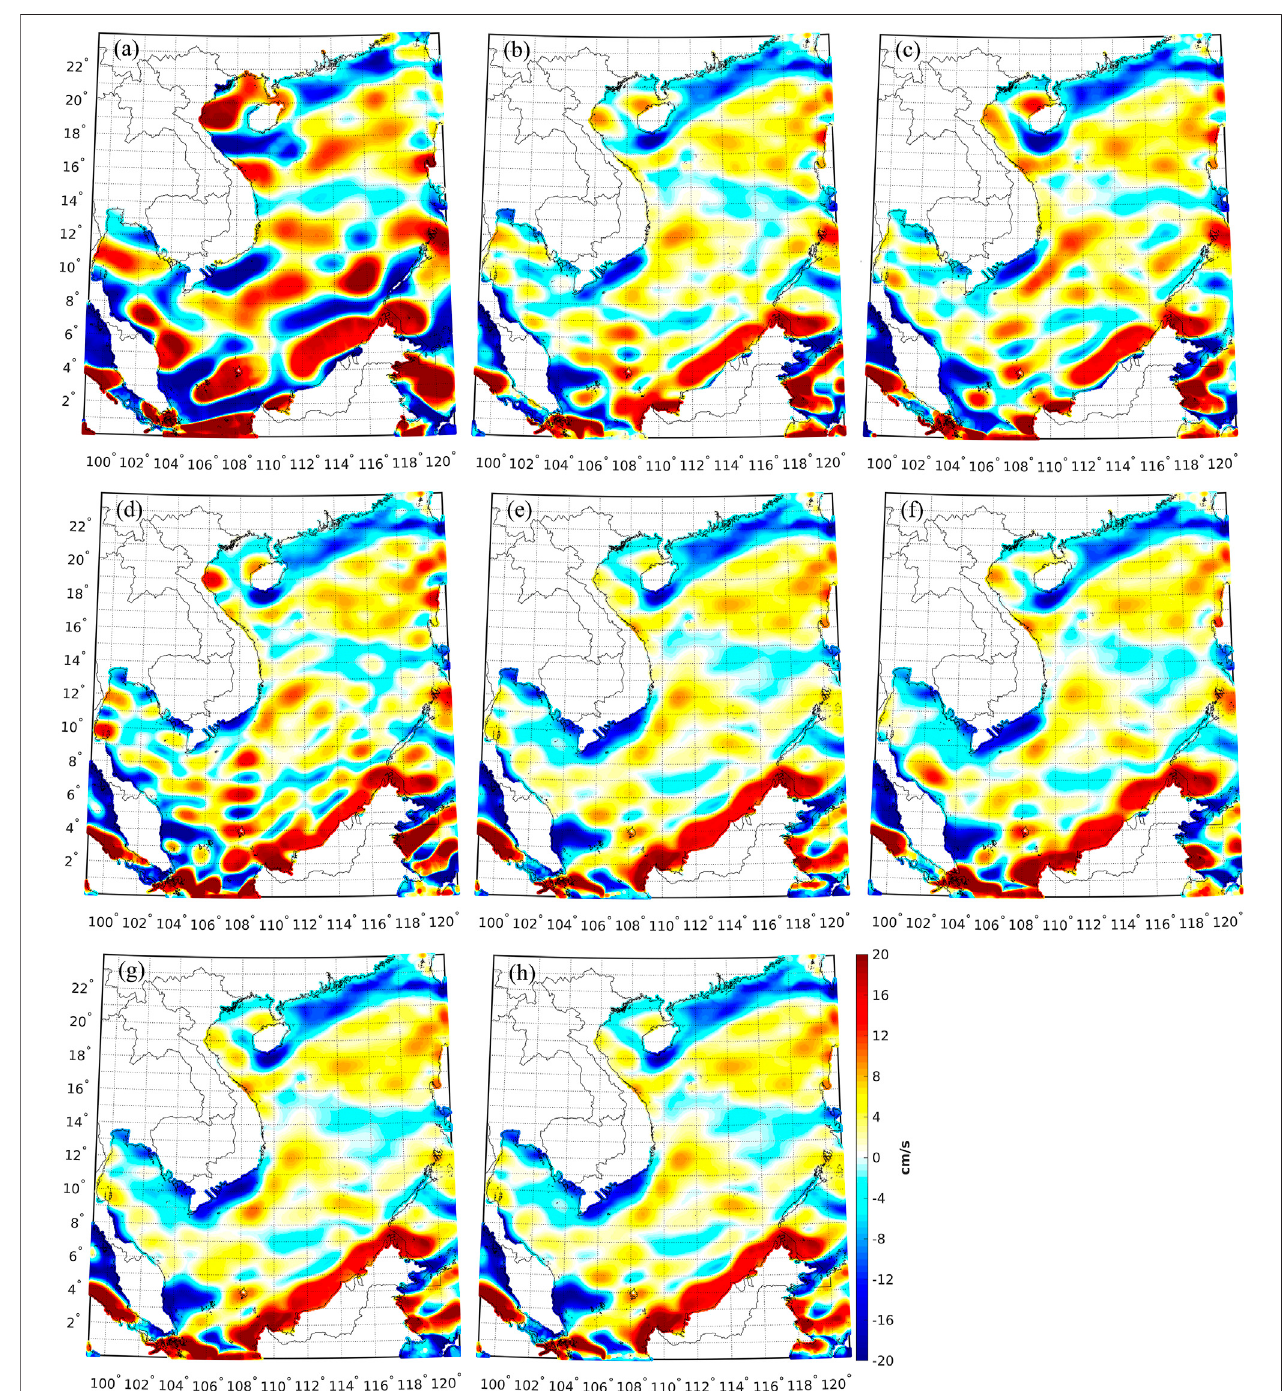
FIGURE 11 | Differences between the zonal velocities computed from the MDT computed from (A) EGM2008, (B) GECO, (C) SGG-UGM-1, (D) EIGEN-6C4, (E) XGM2019e_2159, (F) GOCO05c, (G) XGM2016, (H) XGM2019 and the mean of the zonal velocities derived from all synthetic/ocean data.